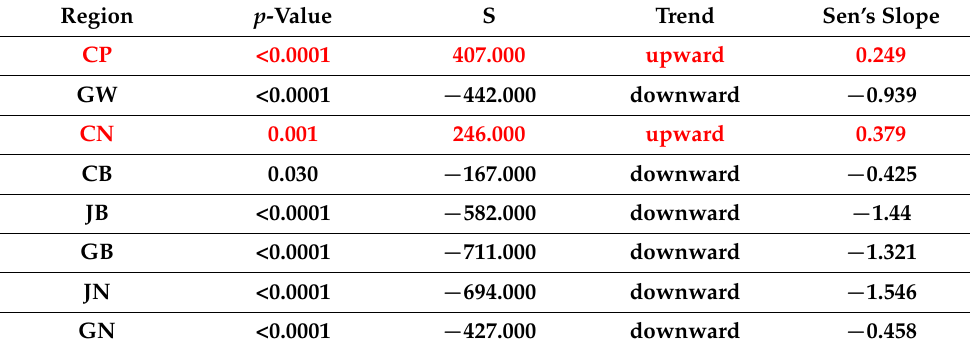
Table 2. Seasonal Mann–Kendall trend analysis for each region. Region p -Value S Trend Sen’s Slope CP <0.0001 407.000 upward 0.249 GW <0.0001 − 442.000 downward − 0.939 CN 0.001 246.000 upward 0.379 CB 0.030 − 167.000 downward − 1.44 GB <0.0001 − 711.000 downward − 1.321 JN <0.0001 − 694.000 downward − 1.546 GN <0.0001 − 427.000 downward − 0.458 Bold text are significant results, and red text indicates an increasing